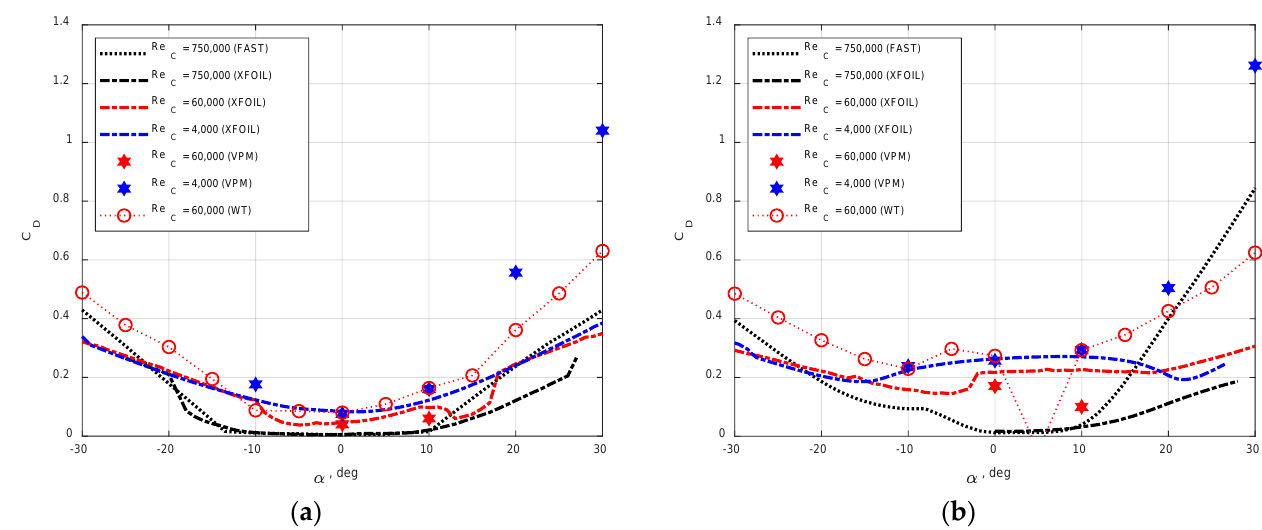
Figure 16. Time-averaged drag coefficients: ( a ) NACA64 and ( b ) DU40.